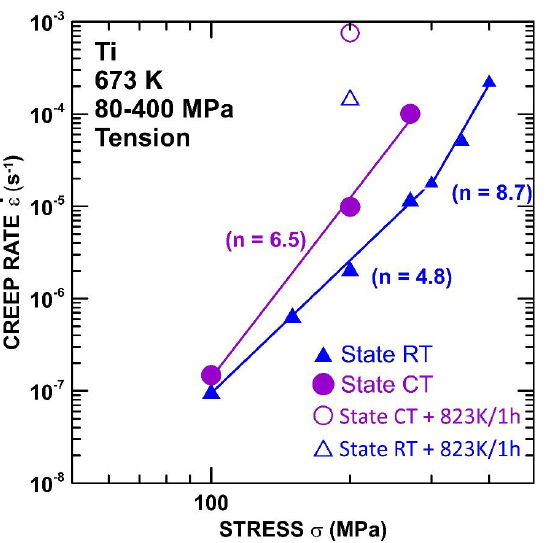
Figure 3. Stress dependences of creep rates determined at 673 K for RT and CT states.